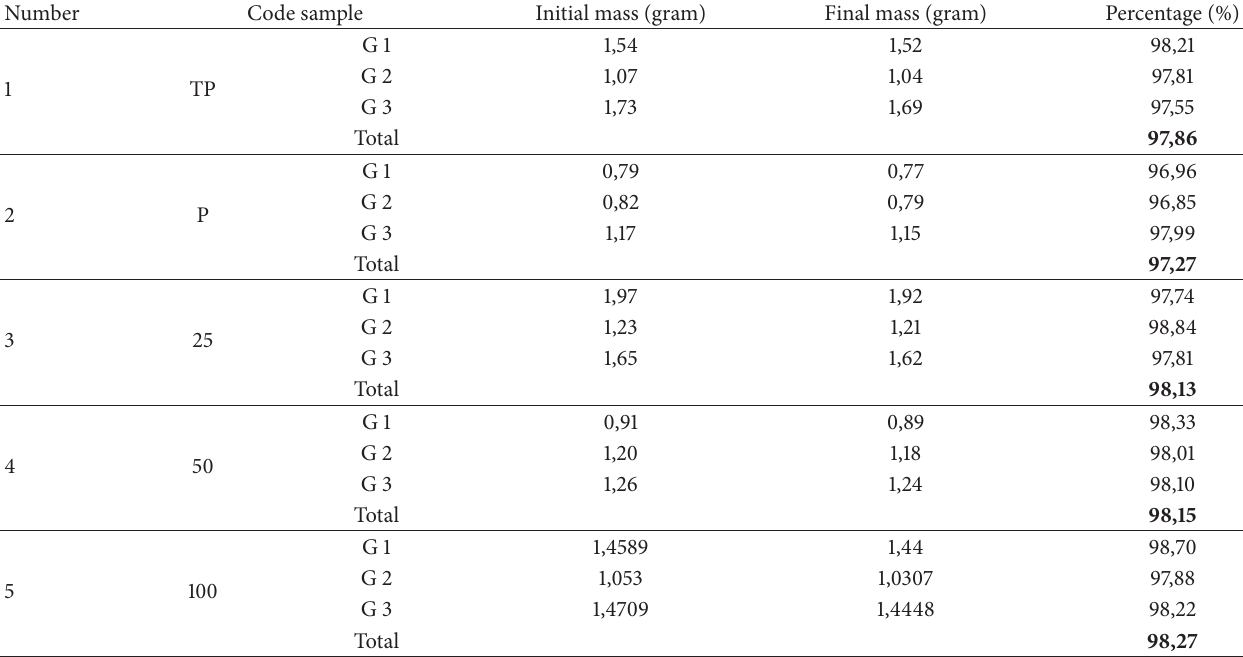
Table 1: Percentage teeth mass remaining on immersion in acetate buffer solution with a certain variation of the treatment for 48 hours.